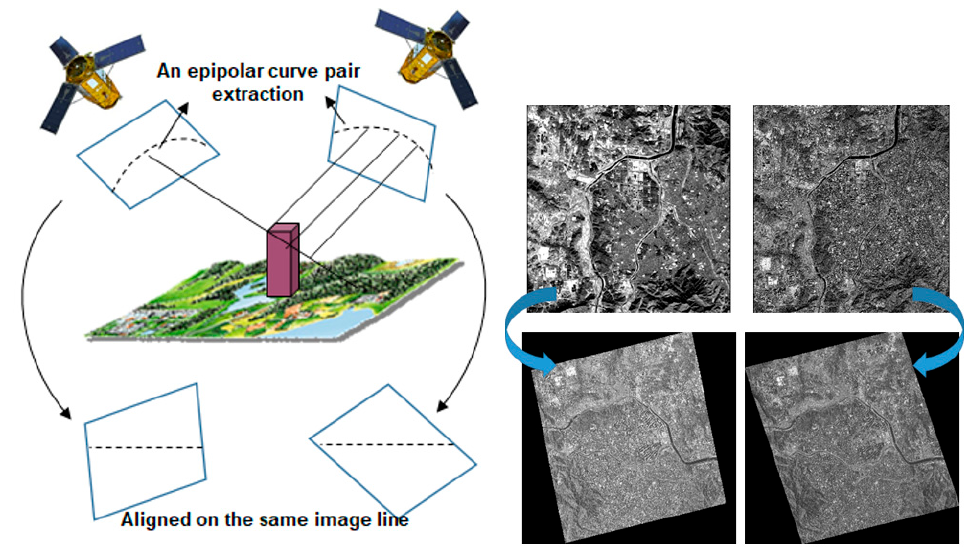
Figure 2. Epipolar image resampling (Oh et al., 2010).